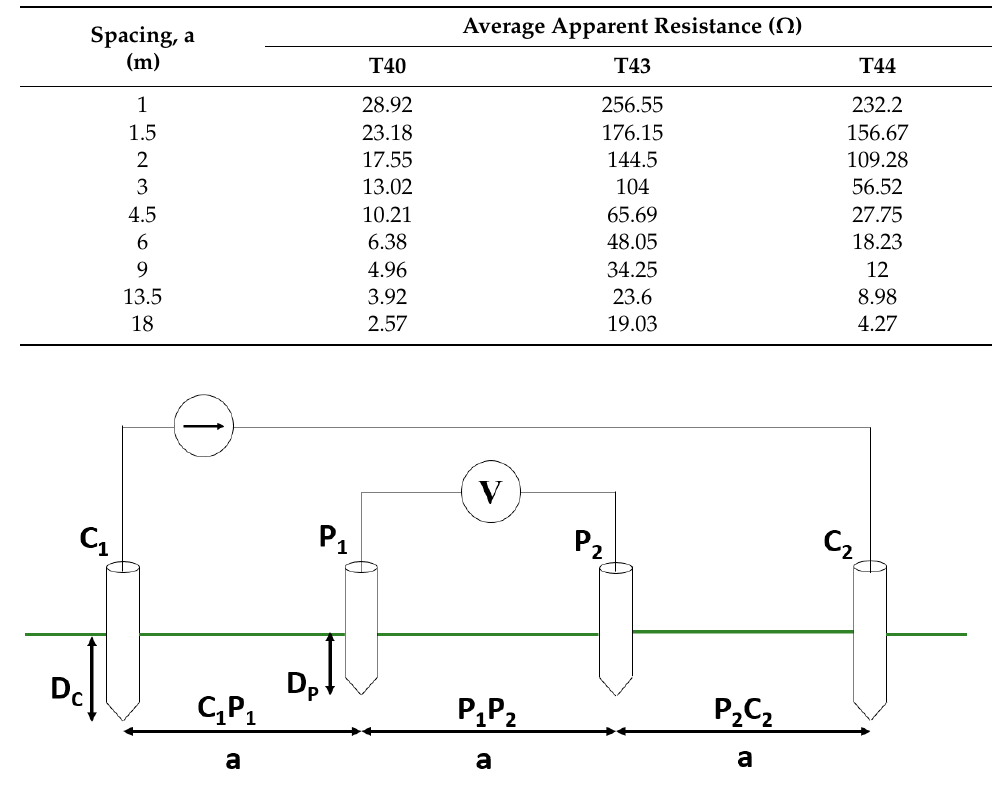
Figure 5. Wenner measurement method.